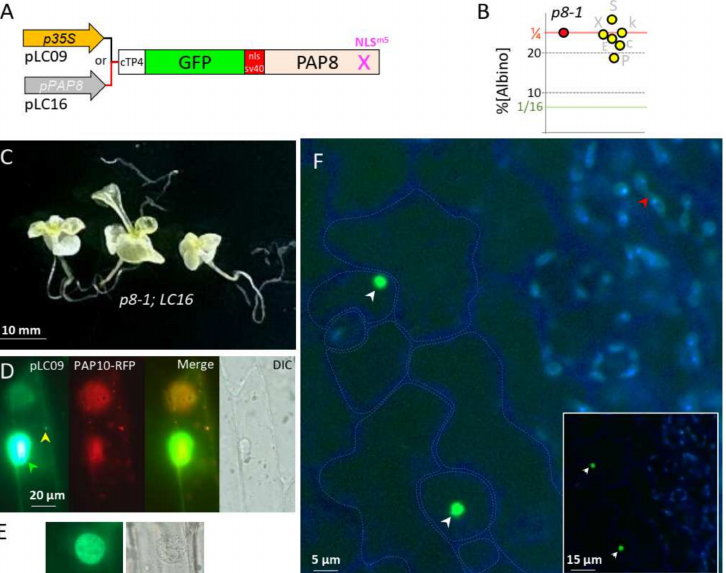
Figure 4. SV40 NLS fused to PAP8 provides a robust nuclear epidermal marker. ( A ) Schematic illustration of the PAP8 recombinant gene: cTP4-GFP-NLS SV40 -PAP8 NLSm5 ; cTP4 corresponds to the chloroplast transit peptide of PAP4 and NLSSV40, the NLS from the simian virus 40 (SV40). The transgene is either under the control of CaMV35S promoter in pLC09 or the PAP8 promoter in pLC16. ( B ) Dot plot of the percentage of albinos obtained in the segregating offspring from the doubly heterozygous-independent T1 for LC16 (yellow dots). A ratio of 1/4 (25%) corresponds to absence of genetic interaction between LC16 and the pap8-1 allele: no complementation. LC16 #E: 137/566 ( ε = 0.441); #X: 201/790 ( ε = 0.285); #P: 118/616 ( ε = 3.685); #k: 138/536 ( ε = 0.395); #S: 199/682 ( ε = 2.4); #c: 152/667 ( ε = 1.361); sum: 945/3857 ( ε somme = 0.720 < U 5% = 1.96). ( C ) 30-day-old phenotype of the genotype pap8-1 , pap8-1 ; LC16. ( D ) Transiently expressed pLC09 (p35S::cTP8- GFP-PAP8 ∆ cTP ) in onion epidermal cells; dual localization in the nucleus (green arrowhead) and in plastids (yellow arrowheads); PAP10-RFP was used as internal positive control for transfection. DIC, differential interference contrast image. ( E ) Non-saturated image of a nucleus and its corre- sponding DIC image. ( F ) Confocal imaging of Arabidopsis cotyledons stably expressing pP8::cTP4- GFP-NLS SV40 -PAP8 ∆ cTP during skotomorphogenesis; the picture is a merge of two channels: GFP in green: protochlorophyllide in blue; the blue channel has been electronically saturated to draw the cell contours in the epidermal layer; inset is the original image. White arrows show nuclei; the red arrow show reduced GFP